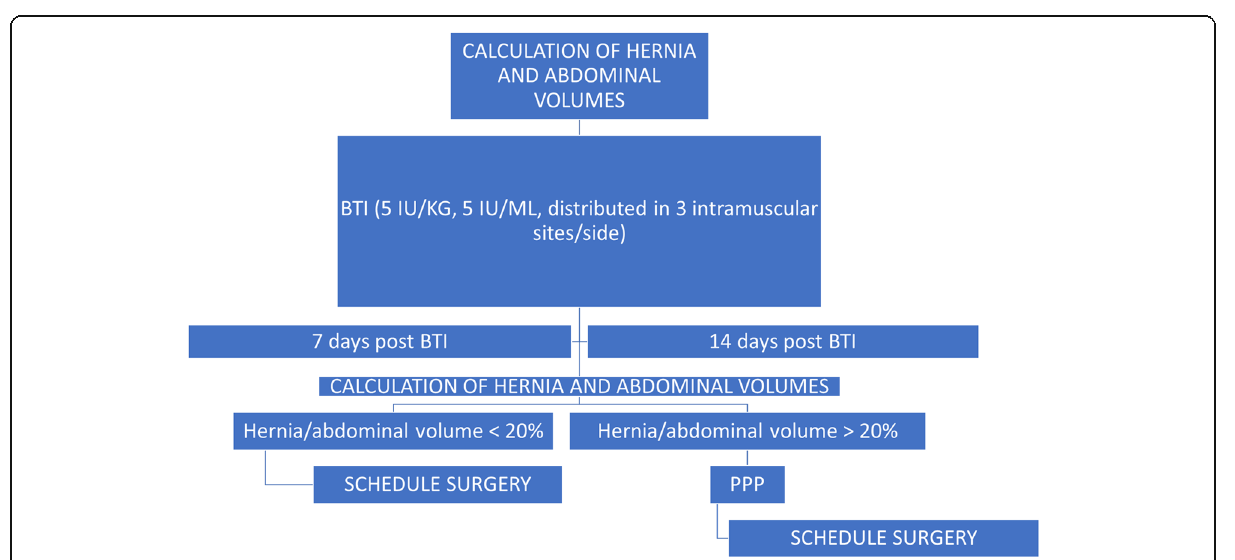
Fig. 1 Proposed algorithm for the treatment of